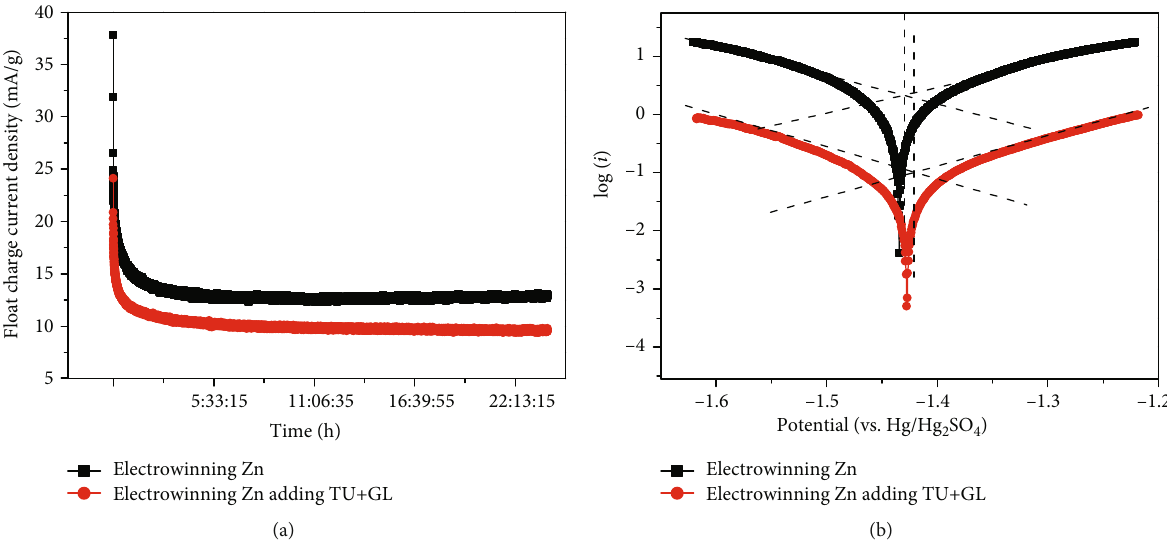
O //Zn at 0.2 C - rate at high temperature and (b) the Tafel curves of di ff erent zinc current 2 4